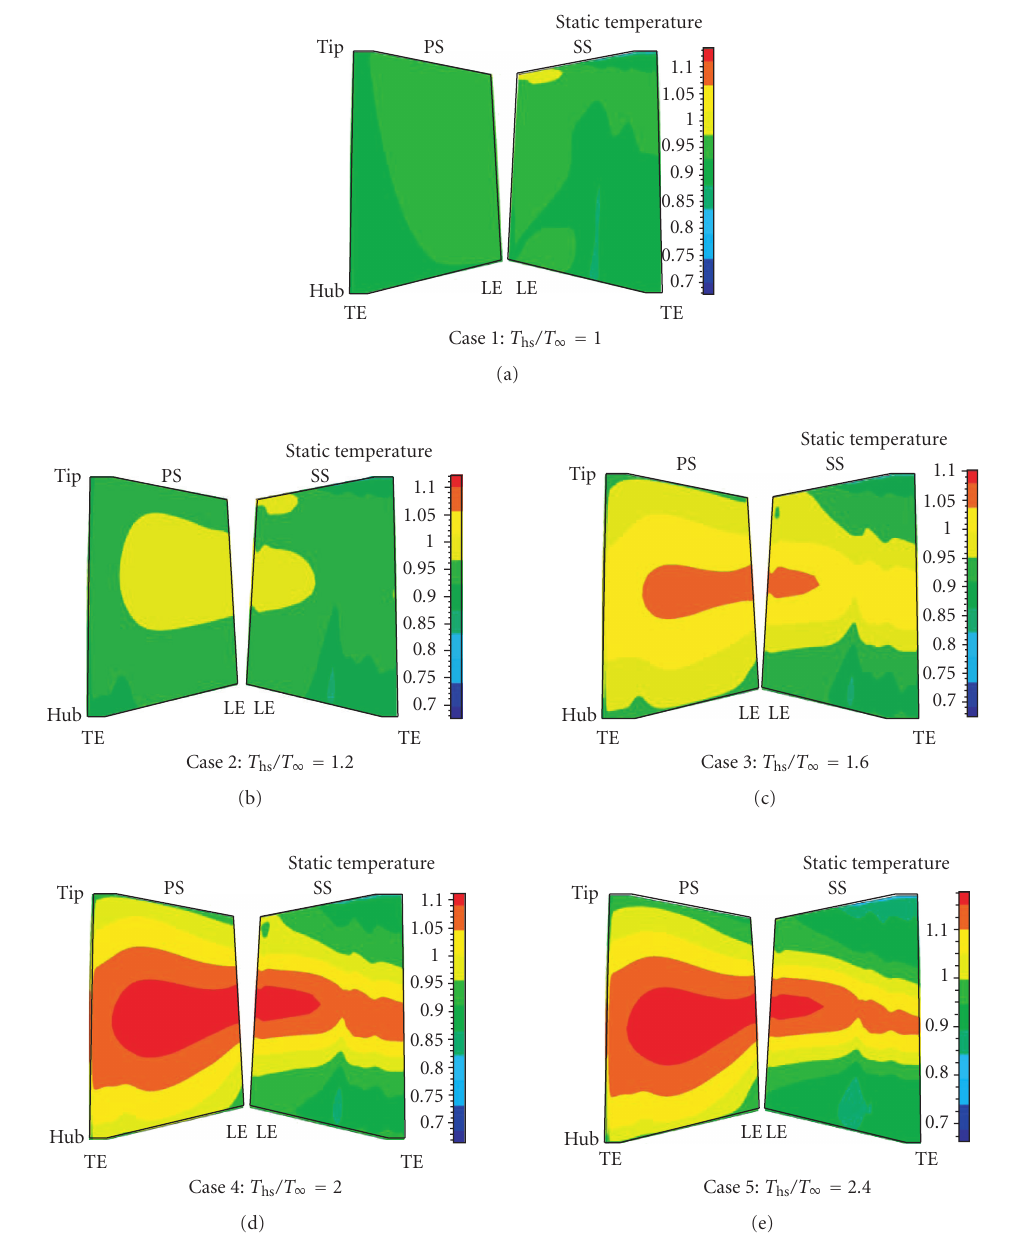
Figure 12: Time-averaged static temperature contours on the HPT